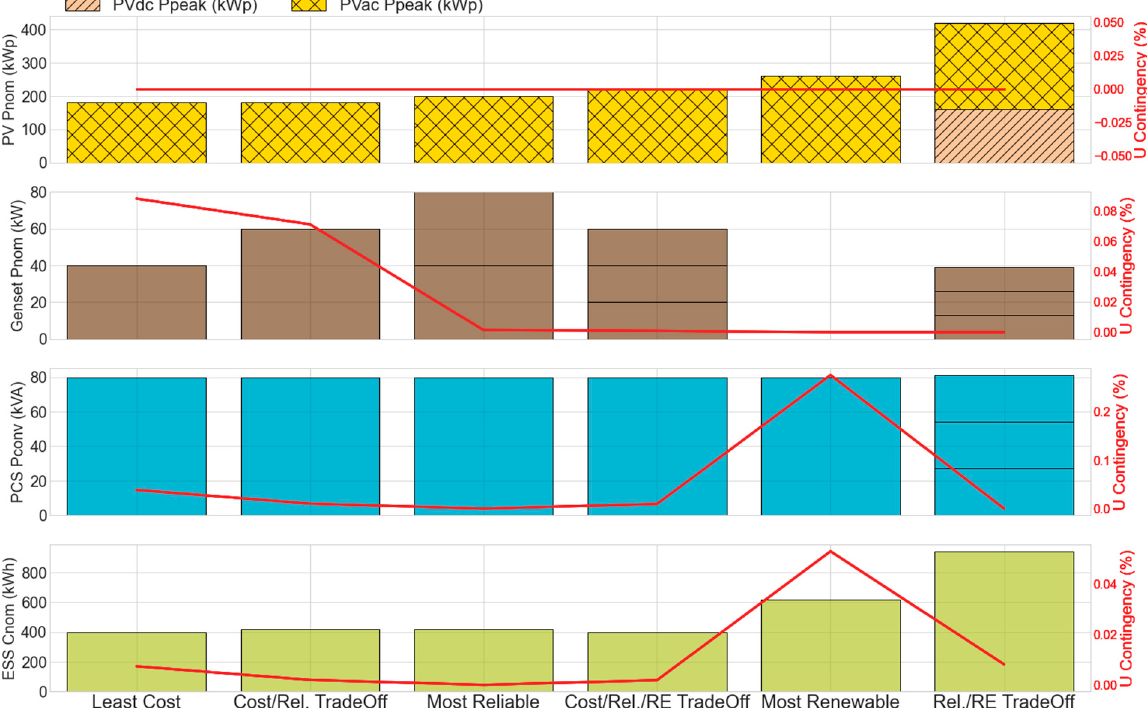
Figure 10. Component sizes for the six selected solutions with unavailability contribution.